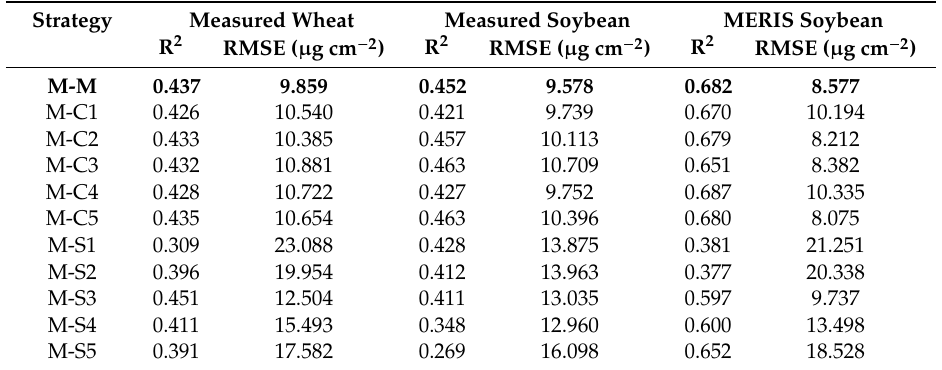
Table 7. Comparisons of LCC retrieval performance using di ff erent inversion strategies. The results in bold are the results obtained using the inversion strategy proposed in this